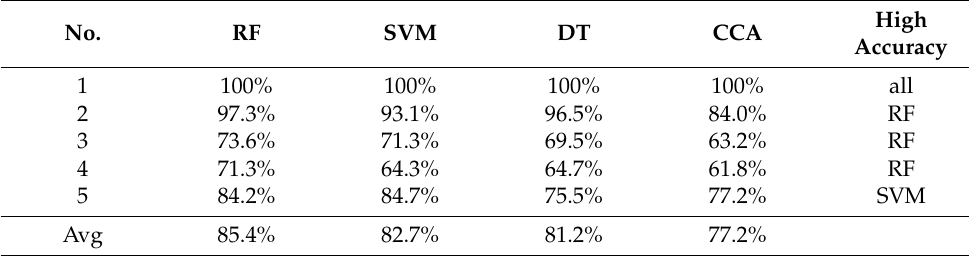
Table 5. Comparing CCA with other three classification algorithms.